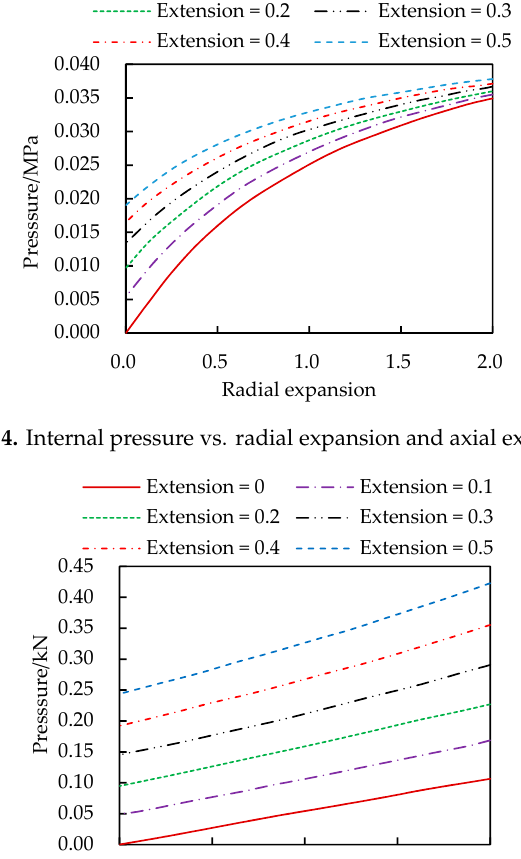
Figure 5. Axial load vs. radial expansion and axial extension.